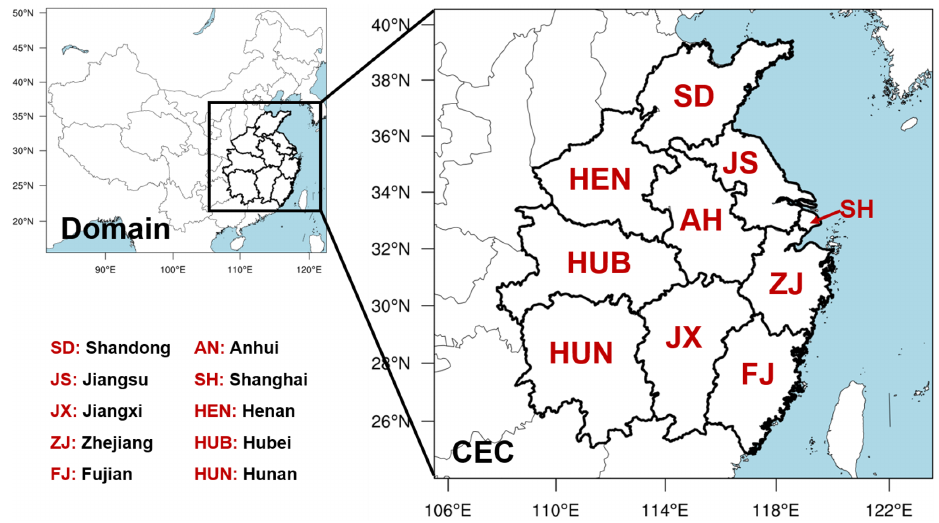
Figure 1. Model domain and geographical areas of CEC. Thick black lines outline boundaries of 10 provinces belonging to CEC, including Anhui (AH), Hubei (HB), Henan (HEN), Hunan (HUN), Shandong (SD), Zhejiang (ZJ), Jiangsu (JS), Shanghai (SH), Fujian (FJ) and Jiangxi (JX). The maps were created by NCAR Command Language (NCL) (http://www.ncl.ucar.edu/, last access: 18 December